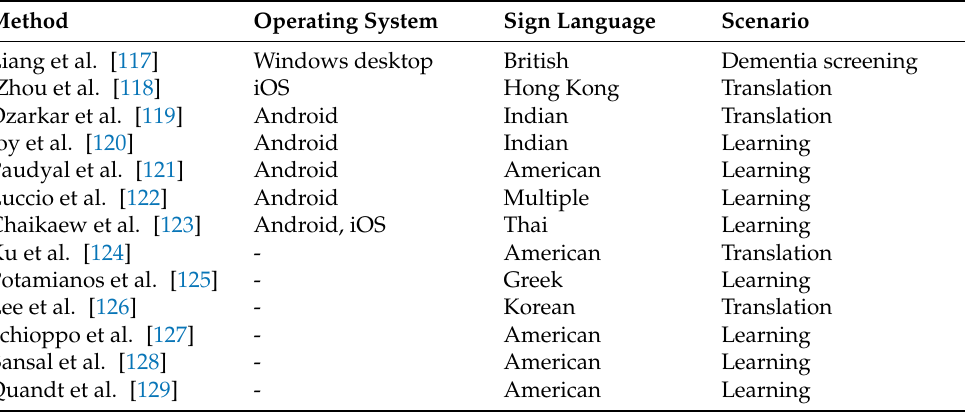
Table 5. Characteristics of sign language